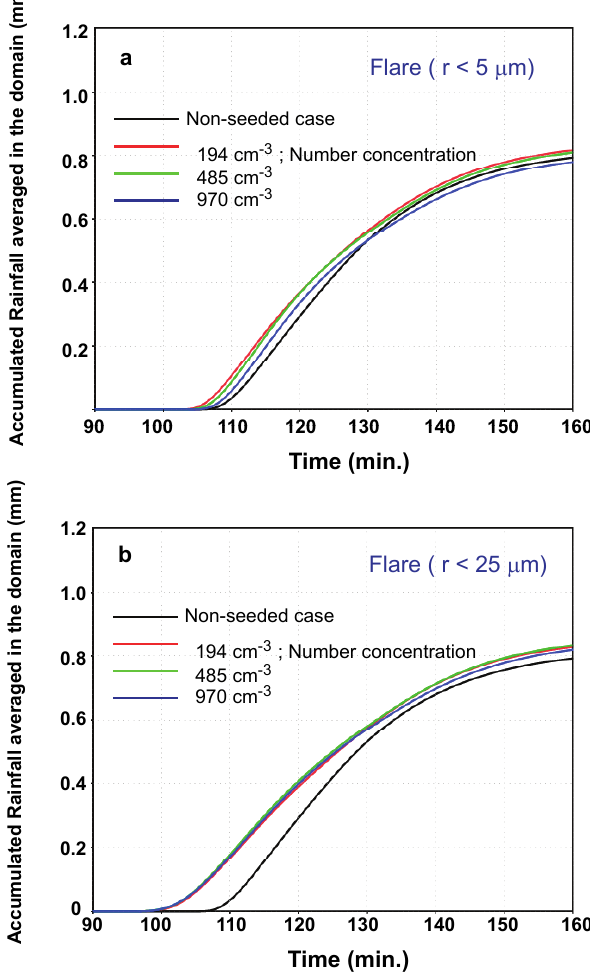
Fig. 13. Same as Fig. 12 except for stratiform